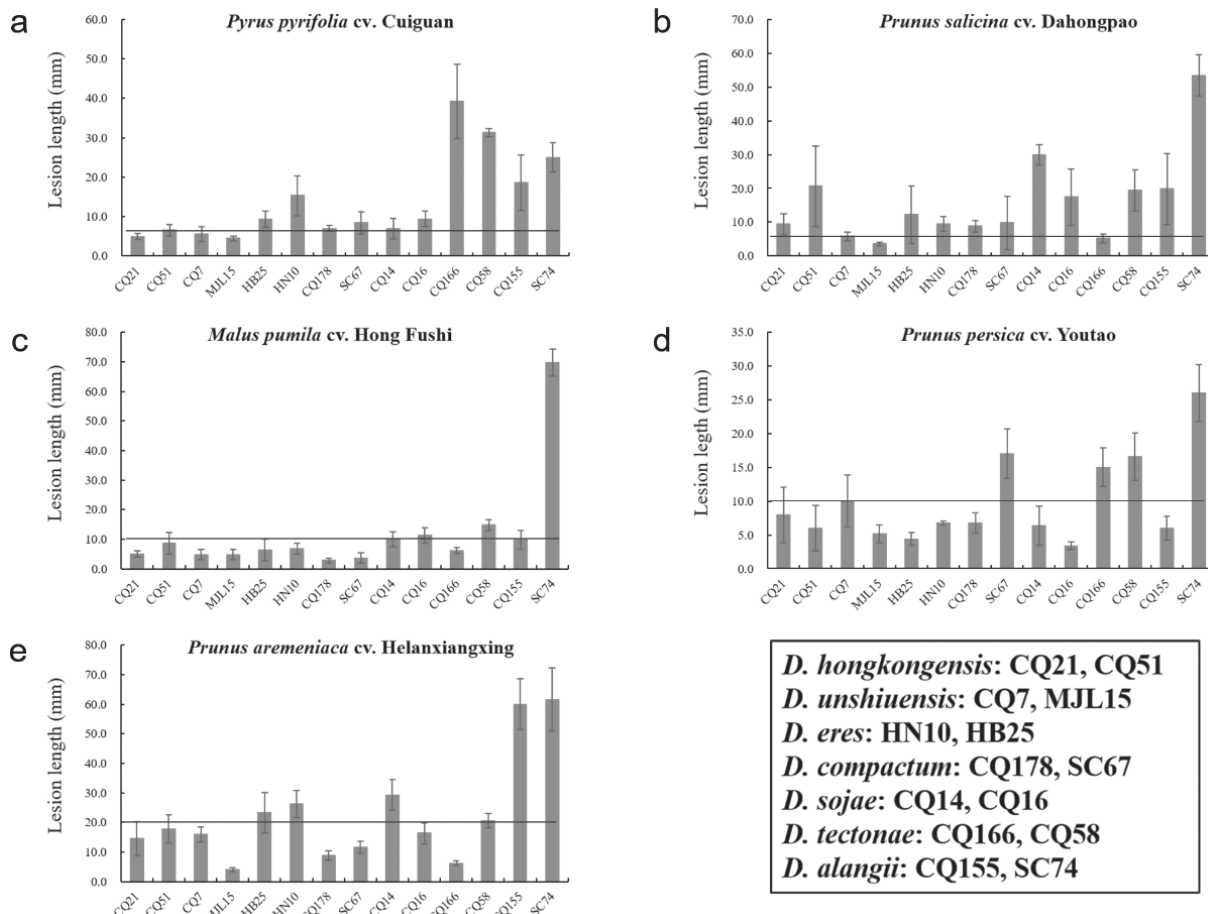
Figure 8. Mean lesion lengths on wounded shoots of pear, plum, apple, peach, and apricot, at 10 d post-inoculation, induced by mycelium plugs from cultures of representative isolates of seven Diaporthe species. a. lesion lengths on shoots of Pyrus pyrifolia ‘Cuiguan’, b, Prunus salicina ‘Dahongpao’, c, Malus pumila ‘Hong Fushi’, d, Prunus persica ‘Youtao’, or e, Prunus aremeniaca